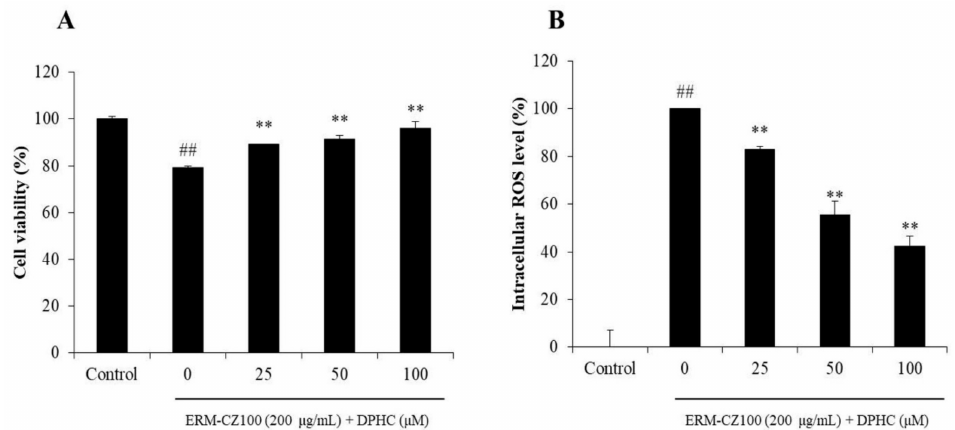
Figure 2. Protective e ff ect of DPHC against ERM-CZ100-induced human dermal fibroblasts (HDF cells) damage. ( A ) Protective e ff ect of DPHC against ERM-CZ100-induced cell death and ( B ) intracellular ROS scavenging e ff ect of DPHC in ERM-CZ100-stimulated HDF cells. Cell viability was measured by